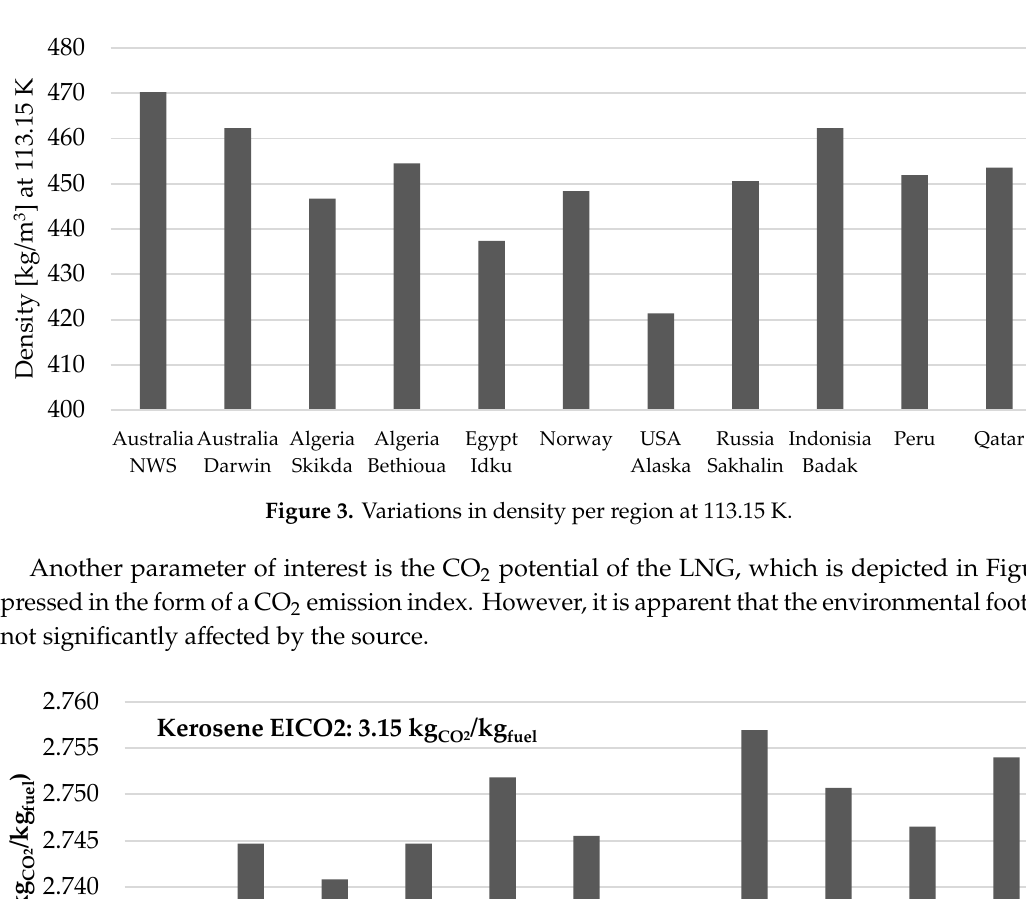
Figure 2. Variations in LHV per Region.